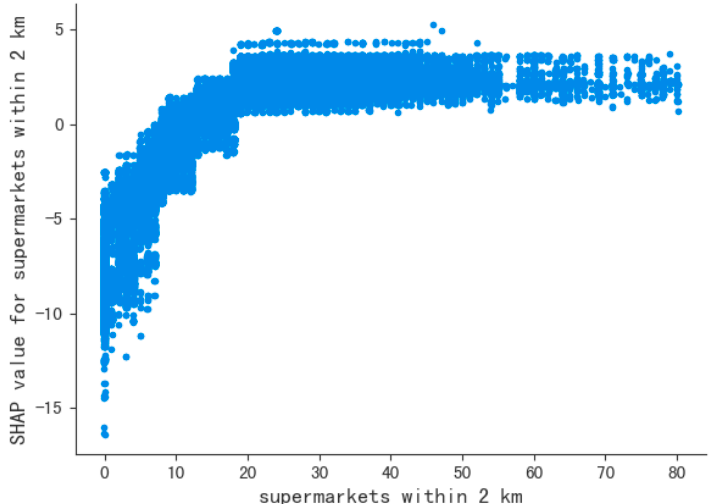
Figure 3. The local influence of “the number of supermarkets within 2 km” on the rental housing price (based on Shapley value analysis).